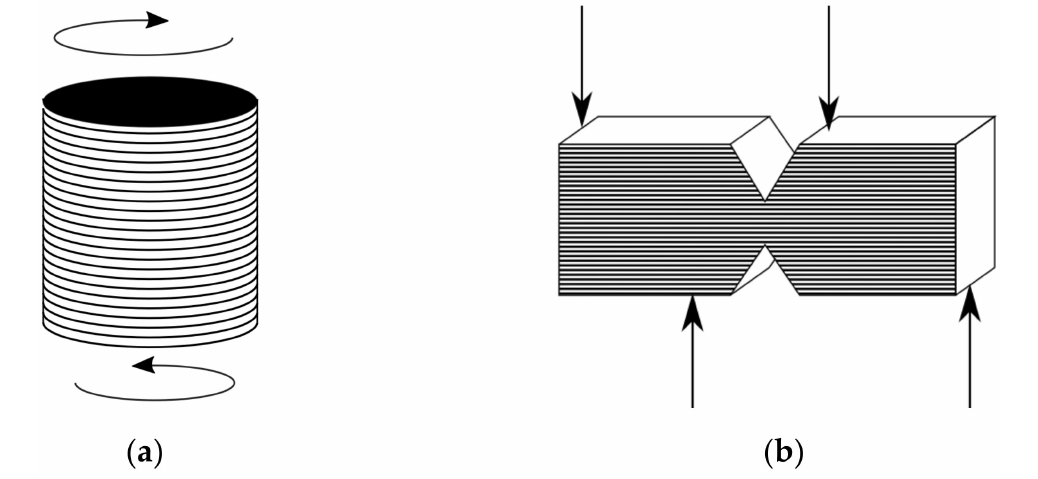
Figure 5. ( a ) Torsion test and ( b ) Iosipescu